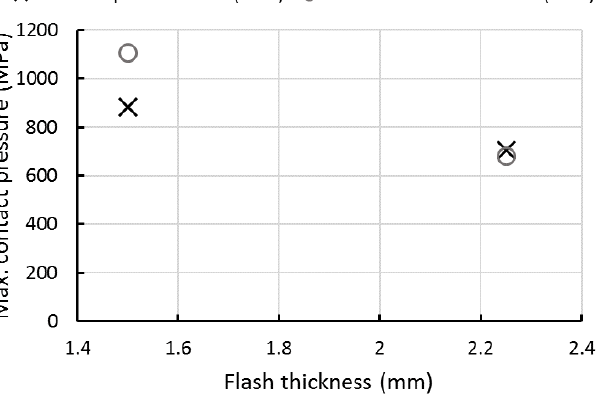
Figure 11. Maximum contact pressure related to the flash thickness and most degraded areas.